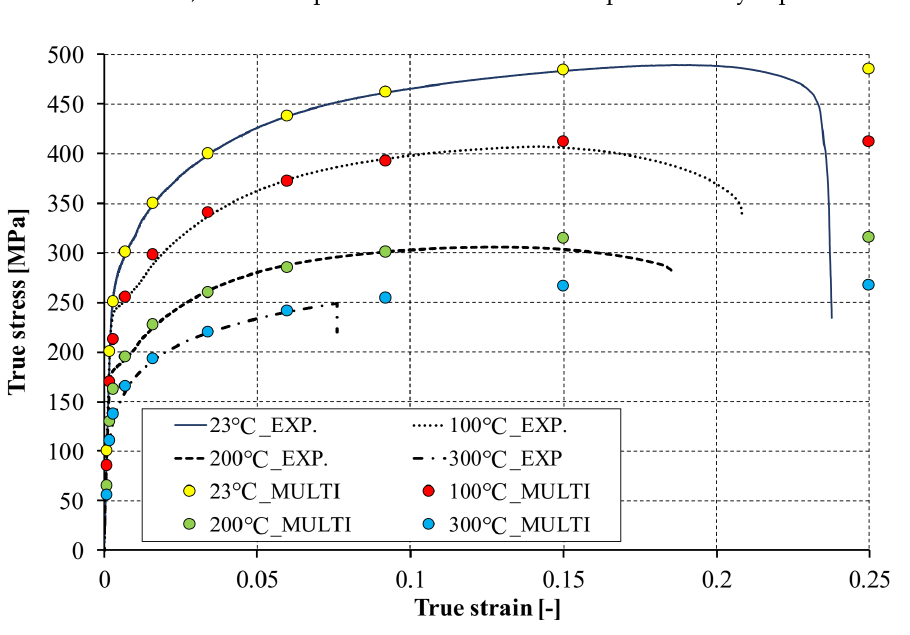
Figure 4. An exemplary true stress vs. true strain curves for considered temperatures. Due to the complex behavior of the material at elevated temperatures, it was decided to implement a multilinear material model as a modification of the nominal curve (determined at ambient temperature). Thus, each of the experimental curves determined at elevated temperature (above 23 ◦ C) was described using ten points with the same strains and a modified stress level. The effect of this approach is presented in Figure 4. The inaccuracy of this approach is that it allows for a stress slightly higher than the tensile strength to be achieved. On the other hand, this approach allows a systematic schematization